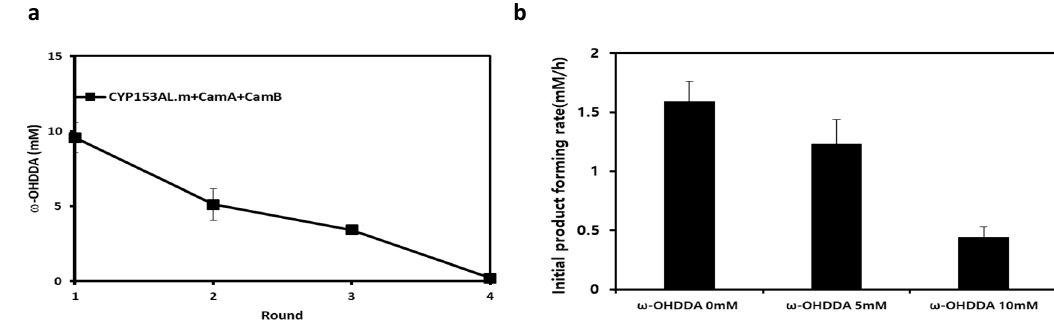
Figure 4. ( a ) Residual stability of whole cells expressing CYP153AL.m. Reaction conditions: Substrate concentration, 20 mM; Volume, 10 mL in 100 mL flask; Temp, 30 °C; Cell type, BW25113 ( Δ fadD, DE3) having CYP153AL.m and CamA/B; Cell OD600, 30; Phosphate buffer, 100 mM; pH, 7.5; glucose 1% ( w/v ), The biocatalysts in the each round (every 6 h) were re-used in next round, ( b ) Product inhibited ω -hydroxylation of 20 mM DDA. Reaction condition is the same with 3 ω -hydroxylation of 20 mM fatty acids by CYP153A and Cam AB containing cells, Note that: 0, 5 and 10 mM of ω -OHDDA was initially added.